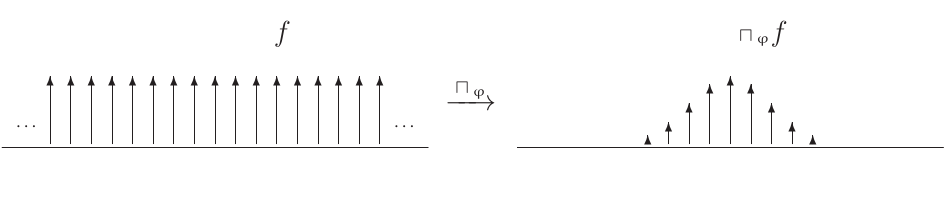
f . ⊓ ϕ f (cid:117) ϕ